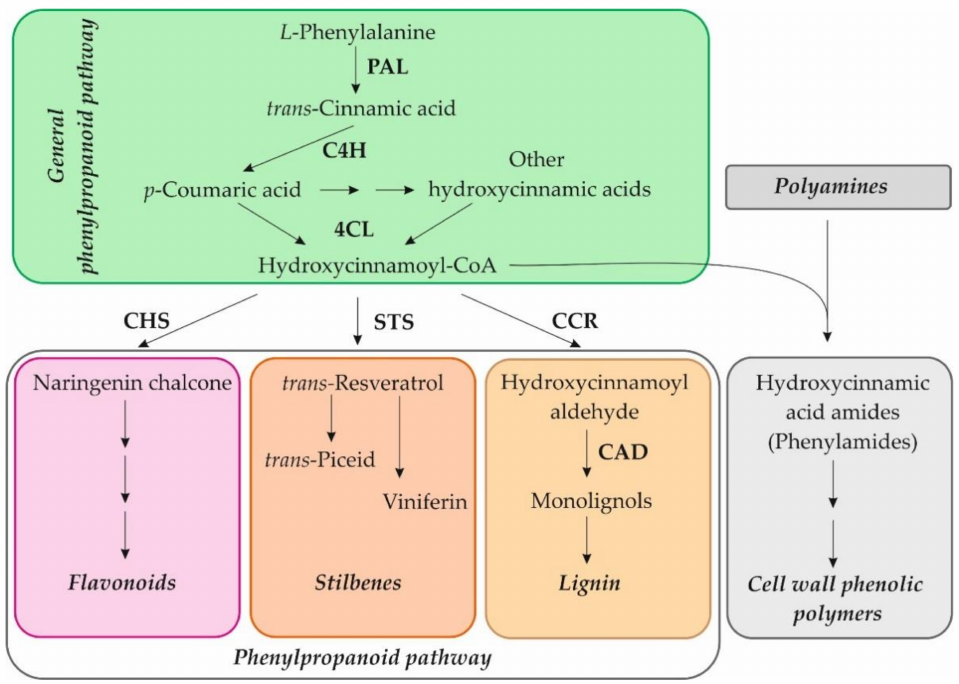
Figure 2. Scheme of the phenylpropanoid pathway and connection to the phenylamide metabolism. PAL, phenylalanine ammonia-lyase; C4H, cinnamate-4-hydroxylase; 4CL, 4-coumarate:CoA ligase; CHS, chalcone synthase; STS, stilbene synthase; CCR, cinnamoyl-CoA reductase; CAD, cinnamyl alcohol